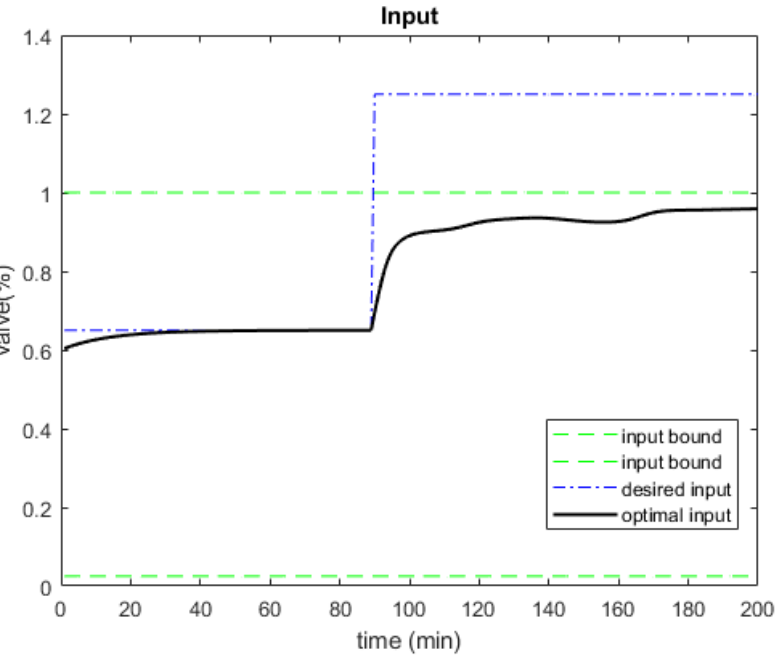
Figure 10. Desired input (blue dash-dotted), optimal input (black solid) and the input bounds (green dash) when the desired input switches from within bound to out of bound. The optimal input approaches the upper bound as far as possible but does not converge to it.